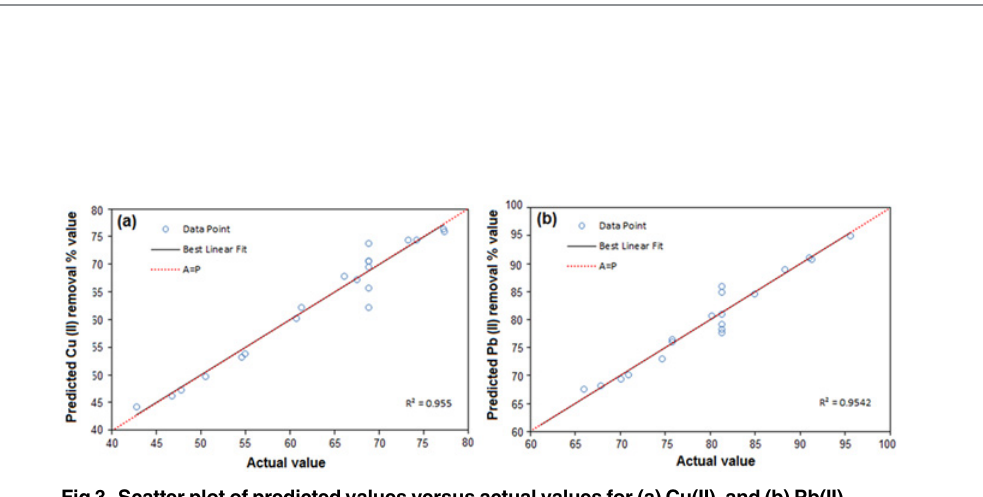
Fig 3. Scatter plot of predicted values versus actual values for (a) Cu(II), and (b)